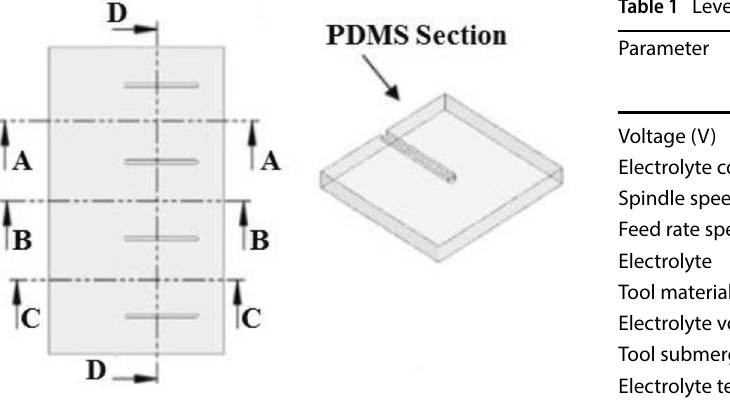
Fig. 3 Cutting cross-section of PDMS piece